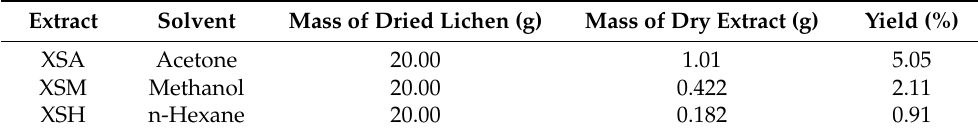
Table 1. Yield of the extraction of the lichen Xanthoparmelia stenophylla with different solvents. Extract Solvent Mass of Dried Lichen (g) Mass of Dry Extract (g) XSA Acetone XSM Methanol XSH